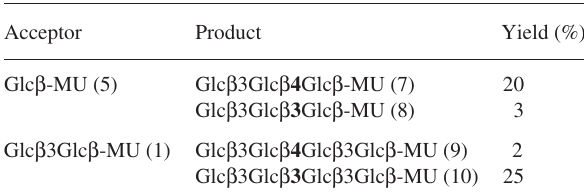
Table 2. Glycosynthase-catalyzed condensations of α -laminaribiosyl fluoride donor (6) with acceptors 5 and 1. Conditions: 100 mM phos- phate buffer, pH 6.5, 50 °C, [donor] = 1 mM, [acceptor] = 5 mM, [en- zyme] = 7.5 µM. Yields were determined by HPLC after a 24-h reaction. Boldface numbers indicate the linkage formed in the con- densation reaction.